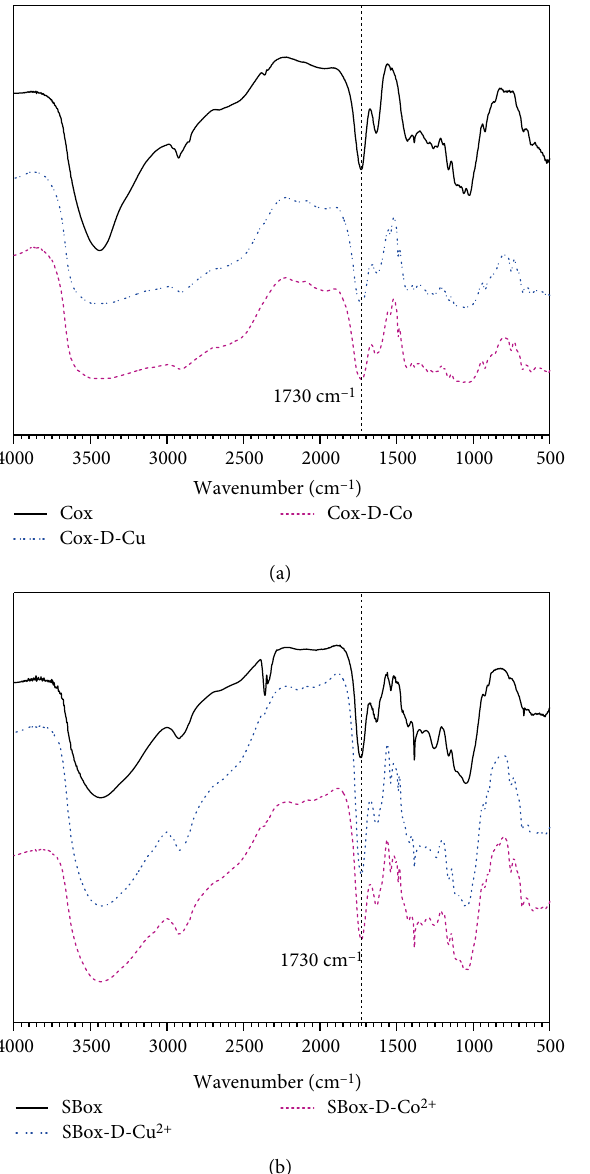
Figure 4: FTIR spectra of (a) Cox, Cox-D-Cu 2+ and Cox-D-Co 2+ and (b) SBox, SBox-D-Cu 2+ and SBox-D-Co 2+ .